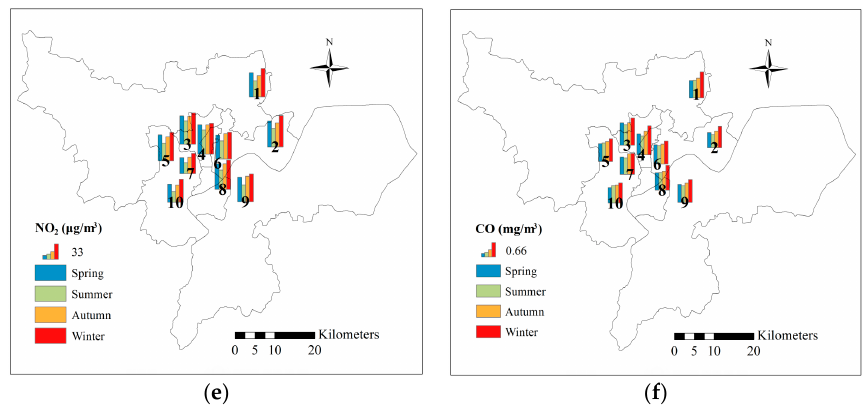
Figure 11. Spatial distribution of seasonal average concentrations of particulate matter and trace gases in Hangzhou City for 2014–2016: ( a ) PM 2.5 ( μ g/m 3 ); ( b ) PM 10 ( μ g/m 3 ); ( c ) SO 2 ( μ g/m 3 ); ( d ) O 3 ( μ g/m 3 ); ( e ) NO 2 ( μ g/m 3 ); ( f ) CO (mg/m 3 ).